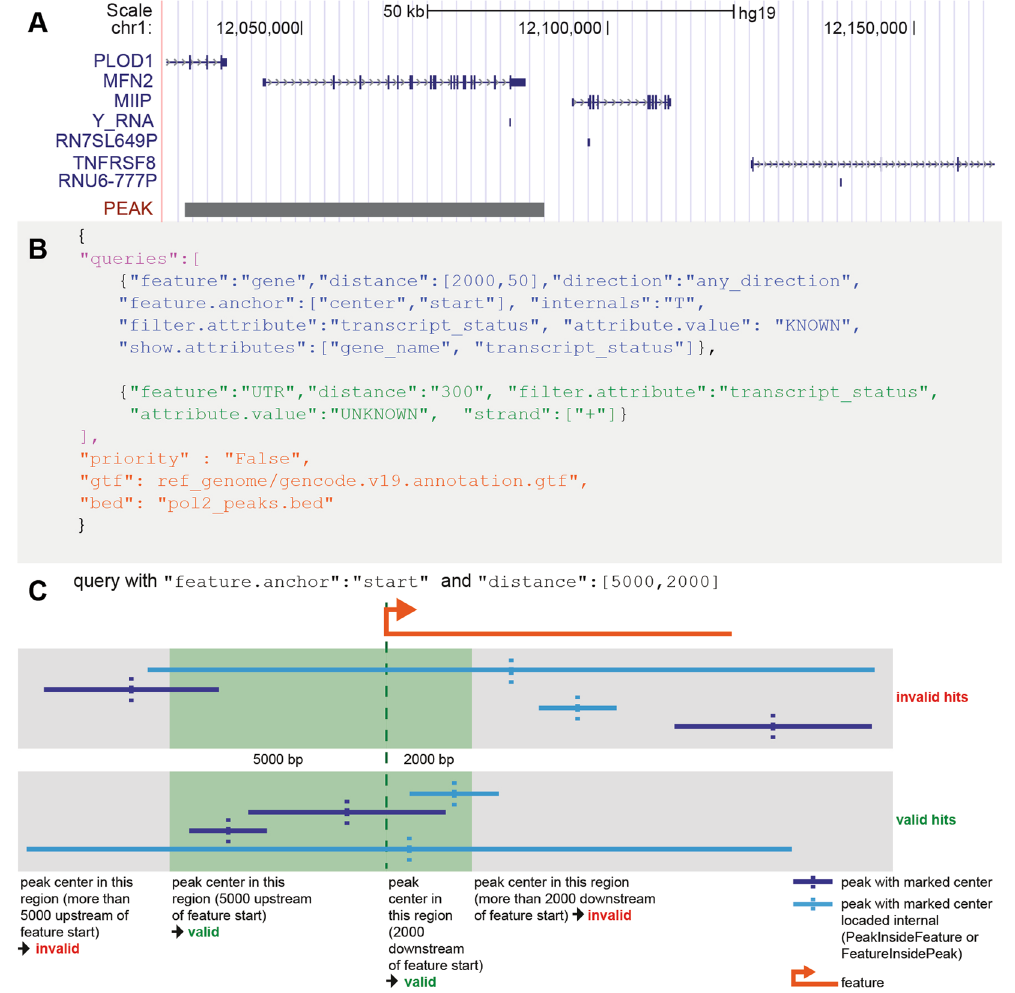
Figure 1. ( A ) Example of a complex annotation situation: region of interest (peak, black bar) overlaps multiple candidate features (blue). These include protein coding genes (PLOD1, MFN2, MIIP, TNFRSF8) with exon (block) and intron (line) structure and non-coding genes (Y-RNA, RN7SL649P, RNU6-777P). Depending on the origin of the peak region the optimal annotation will vary. ( B ) Example on JSON formatted configuration file with two queries: I) begin and end of query section (purple); II) first query targeting gene features with multiple conditions and output filters (key:value pairs, blue); III) second query relating to UTR features (green); IV) global parameters on input files and prioritization. ( C ) Query and feature scheme: Illustration of an oriented feature (orange) and peaks (light and dark blue) that are filtered according to a query with asymmetrical distances as given on top. According to this query, green indicates the valid region around the queried start anchor of the feature. Dark blue peaks centered outside of the green region are never assigned to the feature (upper row, “invalid hits”). Dark blue as well as light blue peaks centered in the green region are assigned to the feature (lower row, “valid hits”). If “internals” key of the query is set to TRUE, light blue peaks given in the upper row are assigned to the